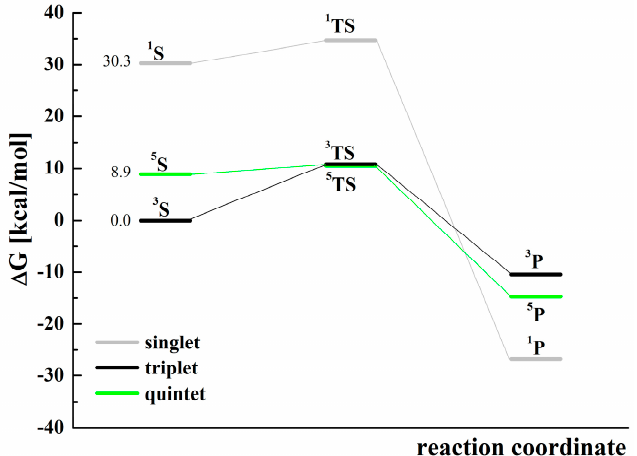
Figure 7. Relative Gibbs free energies (Table S5) of the singlet (1, gray), triplet (3, black), and quintet (5, green) states for the reaction of cyclohexene oxidation by [(N4Py)Fe IV =O] 2+ with the use of MeCN as a solvent model. For the substrates S (in three various spin states), the values of starting relative Gibbs free energies are given next to the corresponding levels. The symbols used: